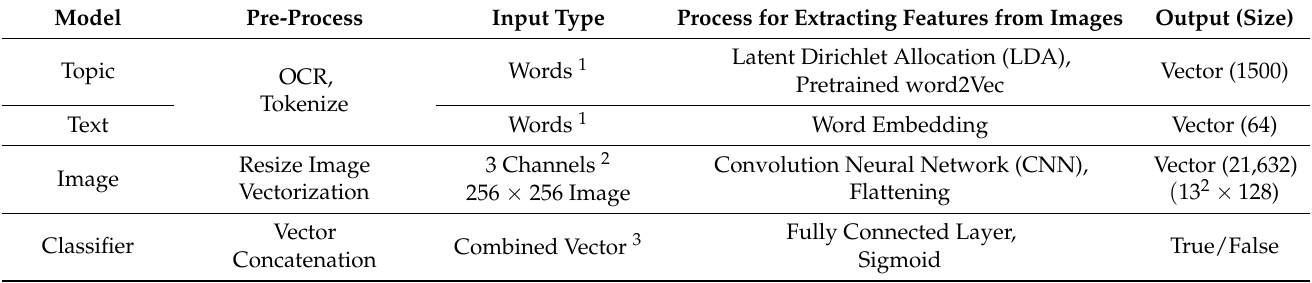
Table 5. Details of each